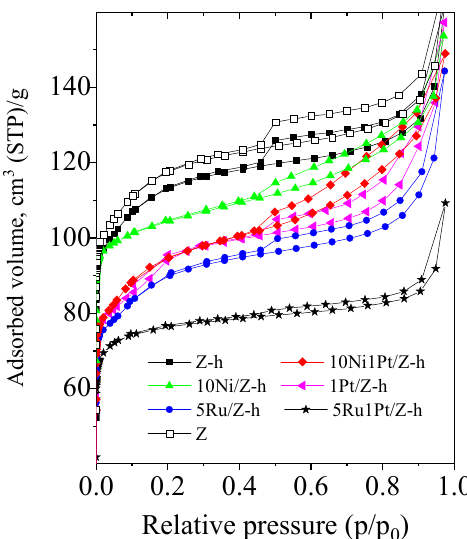
Figure 2. Nitrogen adsorption/desorption isotherms of Z-h and the Ni-, Ru- and Pt-modified Z-h zeolites.